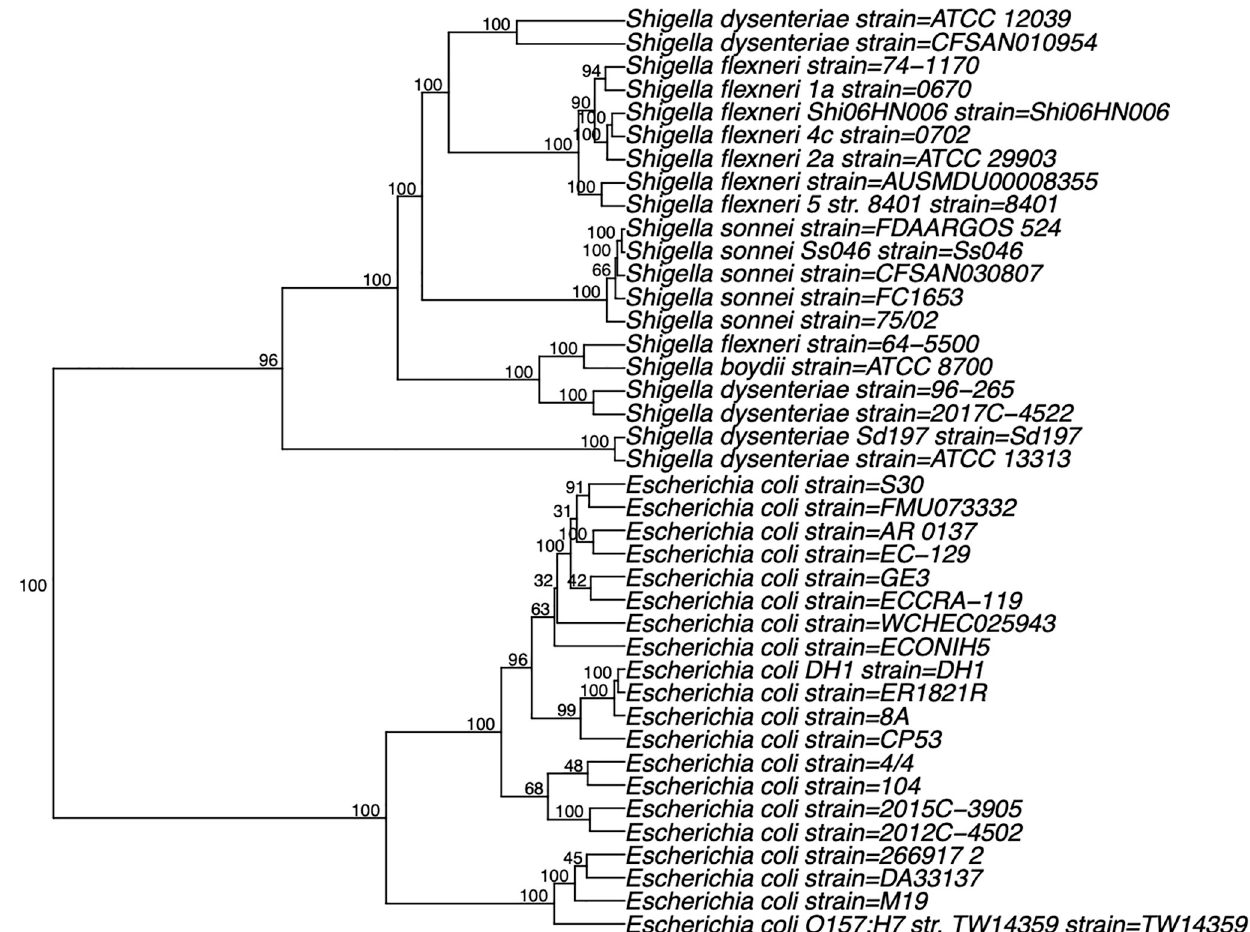
Fig 3. Phylogenetic trees of 20 random sequences from 888 sequences of E. coli and 20 random sequences from 92 sequences of Shigella based on pentanucleotide frequencies.